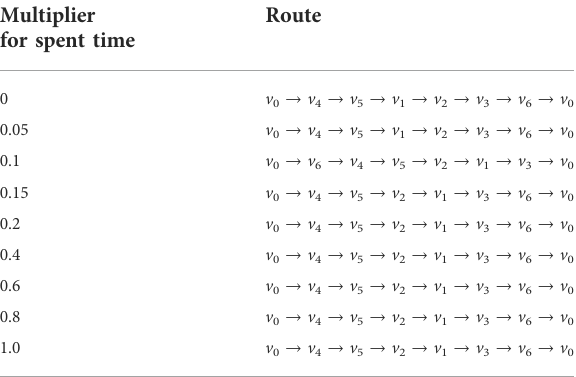
Table 5. The route changed when the multiplier changed from 0.1 to 0.15, and it remained the same for the larger multiplier. In Table 2, the travel times per time slot are 73, 27, 60, 38, and 59 min for routes with departure v 1 and destination v 3 , respectively. When going through the route [ v 0 → v 4 → v 5 → v 2 → v 1 → v 3 → v 6 → v 0 ], ifthespenttimeissuf fi cientlylong (with a multiplier of 0.15 or more), the v 1 → v 3 trip can fi t within the 10: